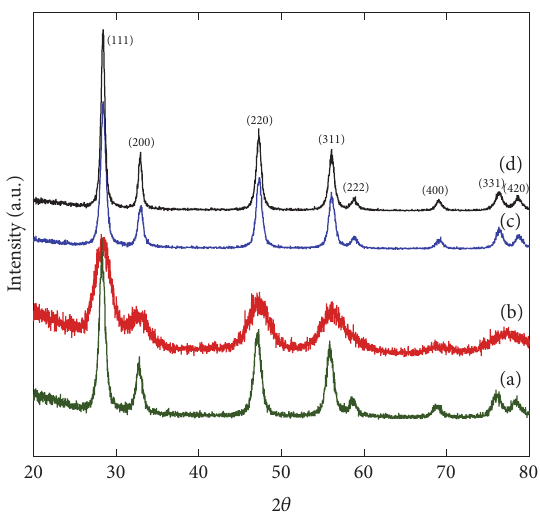
Figure3:XRDpatternsofthesamplescalcinedat600 ∘ Cfor2hours: